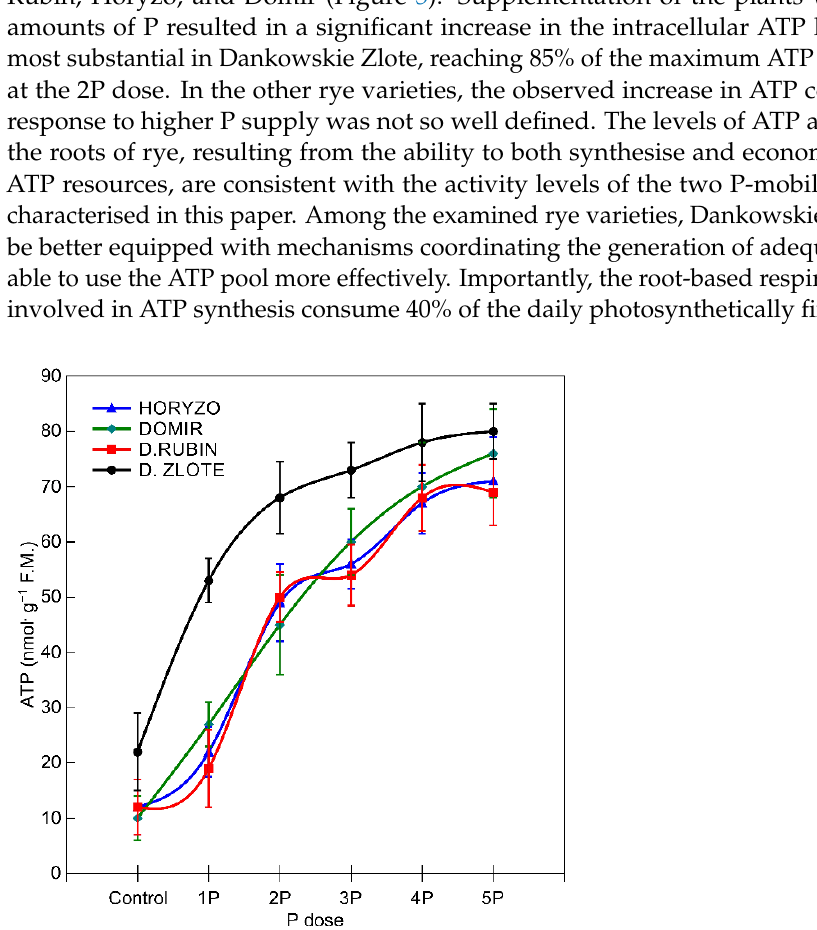
Figure 5. Changes in the intracellular concentration of adenosine triphosphate in roots of rye varieties grown on the post-flotation sediment under variable P supplementation. The fresh root tissue was homogenised in 4.5% perchloric acid and purified, and the ATP content was determined fluorometrically by glycerol phosphorylation at λ ex = 535 nm and λ em = 587 nm. Data represent the means of n = 9 replications, and vertical bars represent 95% confidence interval after a post hoc Tukey HSD test (interaction P dose × variety), with the letters denoting homogeneous groups being omitted for a clear view.